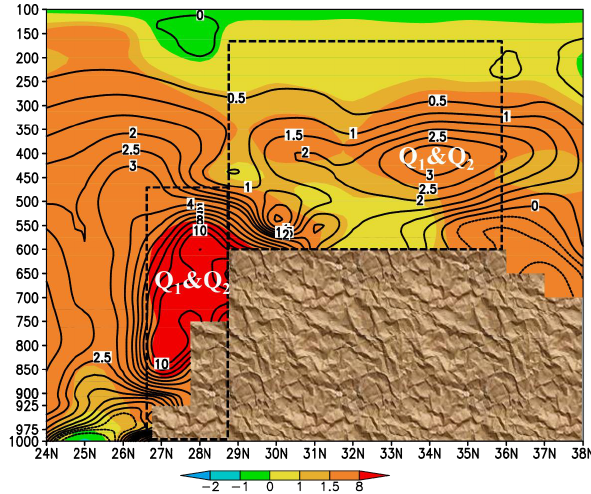
Figure 5. The vertical distributions of apparent heat source Q 1 (filled contours) and apparent moisture sink Q 2 (Wm − 2 ) averaged between 85 and 100 ◦ E in summer over 2000–2009. The Q 1 and Q 2 in two dash rectangles are produced with two ladders of CISK- like process respectively over the TP’s southern slopes and main platform. The plateau section is marked with soil color.